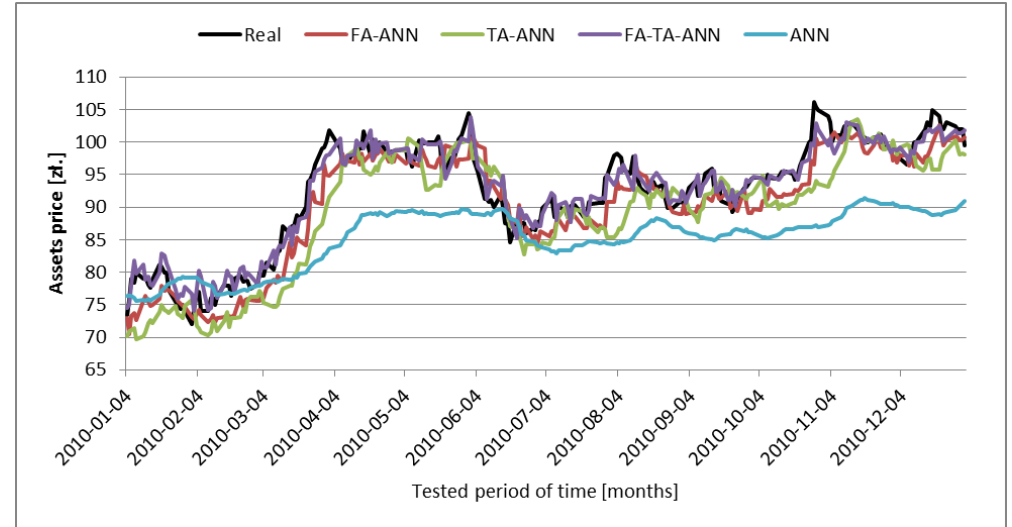
Figure 5. Short-term forecast of ANN-based models and the real CLOSE value for BUDIMEX SA in 2010.